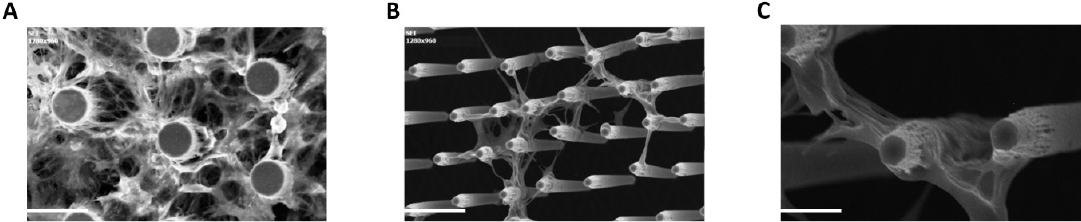
Figure 4. hCPs seeded on silicon slide establish close interactions with micropillars. ( A ) Top-view SEM image showing hCPs seeded at standard density on silicon micropillars. ( B , C ) Cross-sectional SEM images showing hCPs seeded at low density on silicon structures to visualize single cells-micropillars interactions. Scale bar: 20 µm ( A , B ) and 10 µm ( C ).